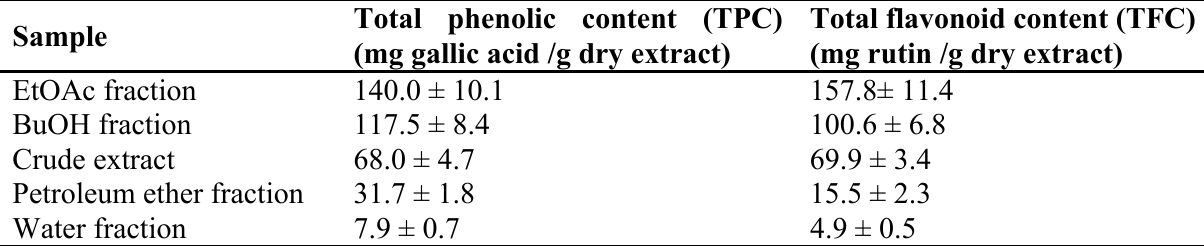
Table 2. Total phenolic contents and total flavonoids contents of crude extract and its derived soluble fractions of C. sinica flowers. Values of each data were means ± SD ( n = 3). P < 0.05.